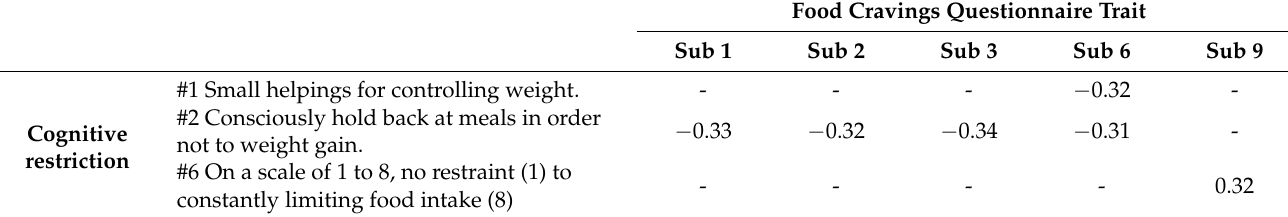
Food Cravings Questionnaire